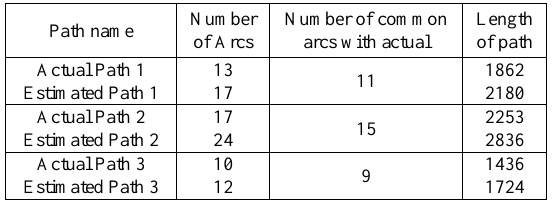
Table 2. Assessing results of point to point method Table 3. Results obtained from point to curve method